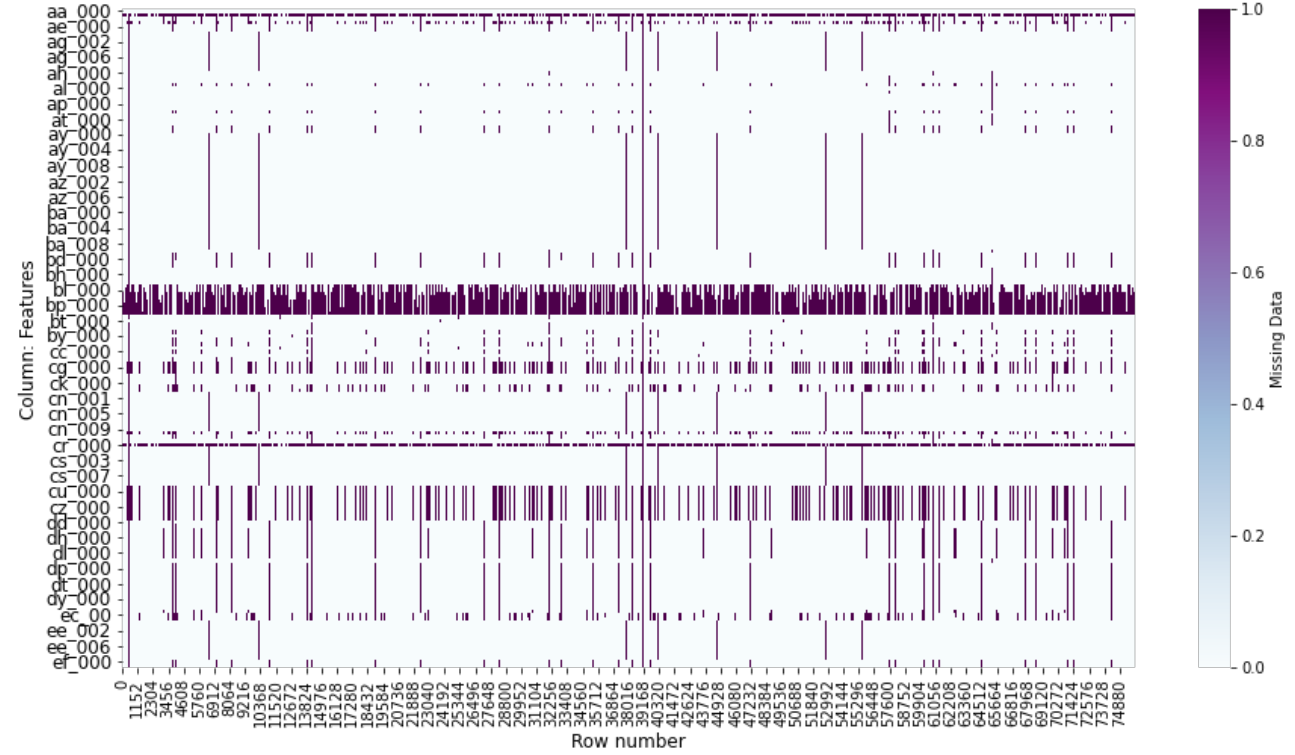
Figure 2. Pattern of the missing values in the data set across the features.